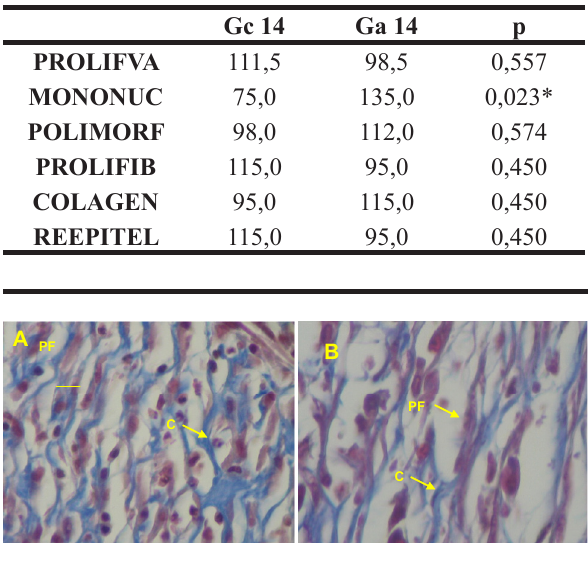
FIGURA 4 - Fotomicrografia de tecido de reparação da pele de ratos - 14 dias de pós-operatório. Legenda: A=Rato 9Ga B=Rato 7Gc - Coloração por tricrômio de Masson,